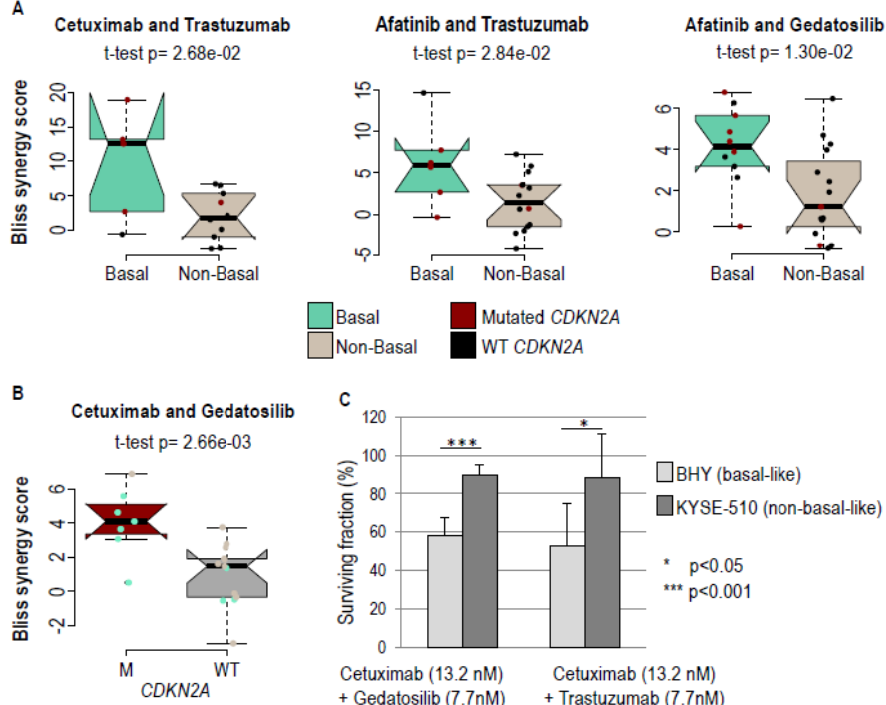
Figure 3. Basal HNSCC cells are sensitive to therapeutic combinations. ( A ) Boxplot of the Bliss synergy scores obtained on basal and non-basal HNSCC cell lines upon treatment with the shown therapeutic combination (Cetuximab and Trastuzumab; Afatinib and Trastuzumab; Afatinib and Gedatosilib). The Bliss scores were found to be significantly higher ( t -test p -values are shown) in basal cells. ( B ) Boxplot of the Bliss synergy scores obtained on wild-type (WT) and CDKN2A mutant (M) HNSCC cell lines upon treatment with Cetuximab and Gedatosilib. CDKN2A mutations are significantly associated with higher Bliss scores. ( C ) Analysis of the clonogenic survival of basal BHY and non-basal KYSE-510 cells upon treatment with Cetuximab and Gedatosilib, and with Cetuximab and Trastuzumab. BHY cells displayed a significantly higher sensitivity to therapeutic combinations. Mean survival fractions and standard errors from three independent experiments are shown.